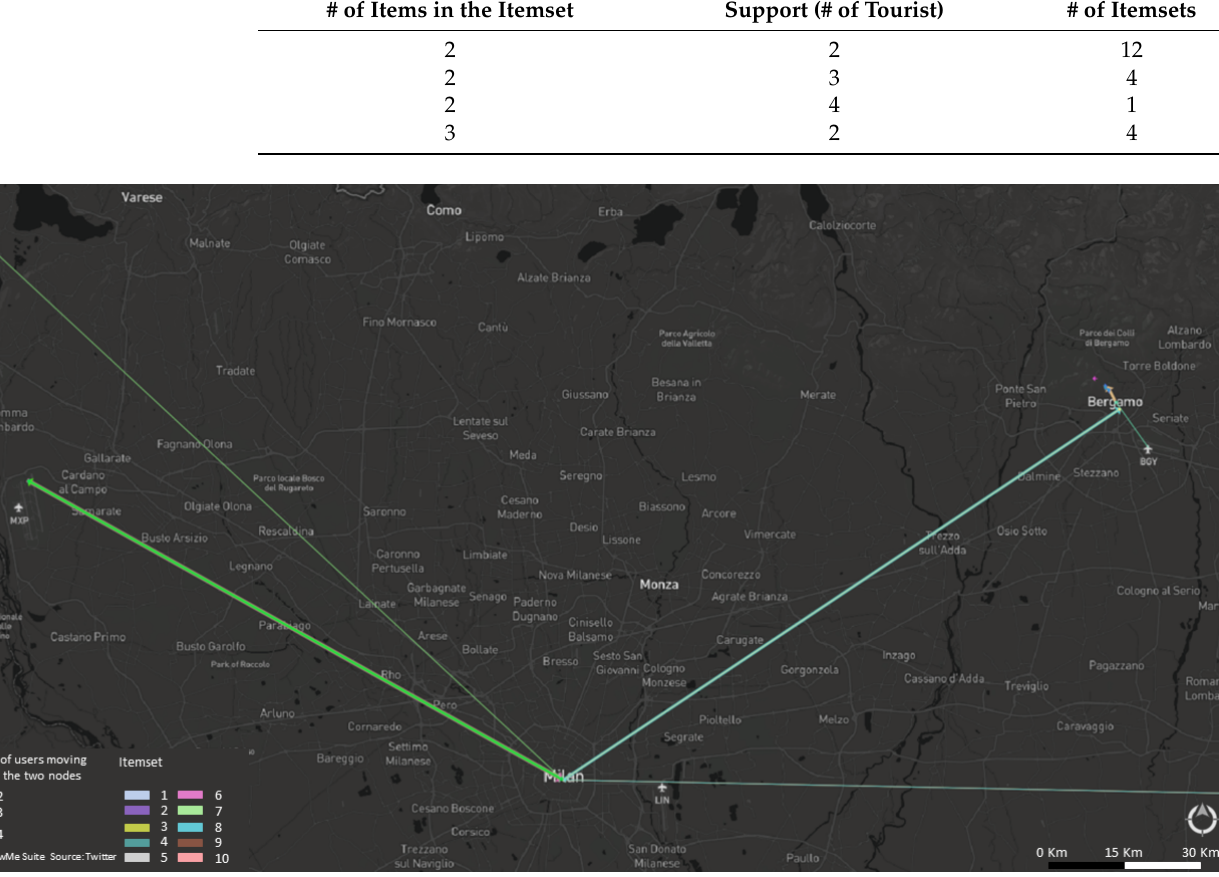
Figure 5. Topographic representation for discovered itemsets associating direct transfers (Interpretation